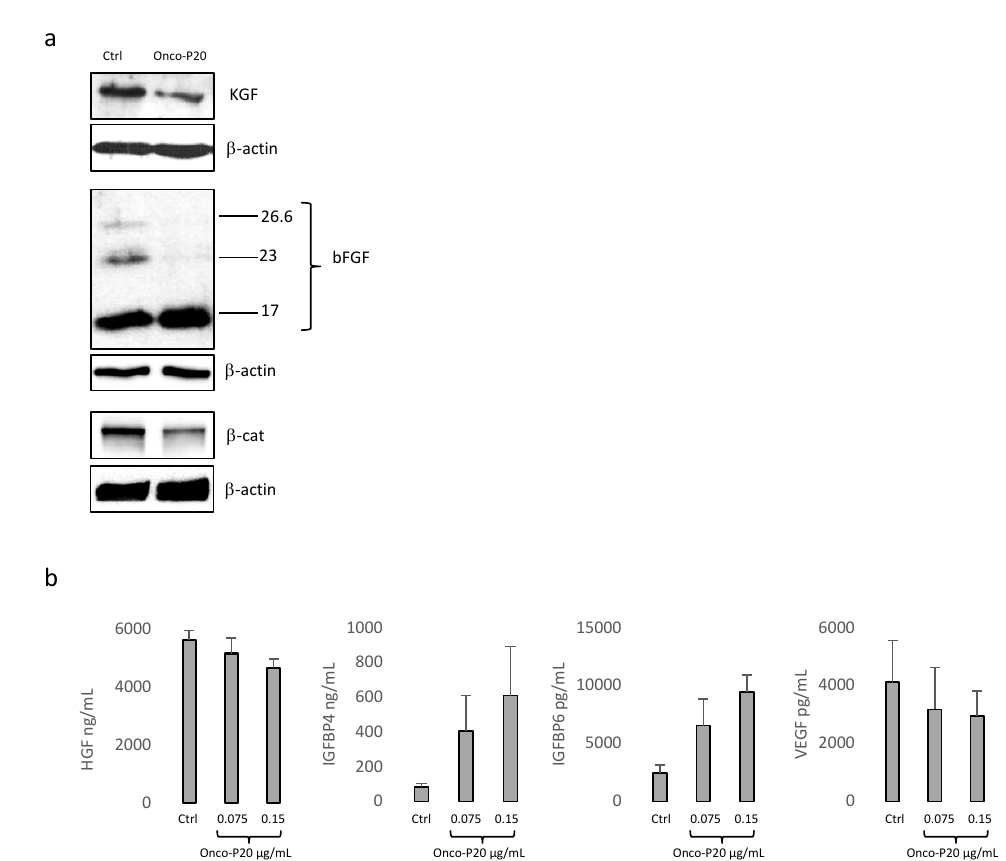
Figure 6. ( a ) One representative Western blot analysis demonstrating the reduction in growth factors and β -catenin expression in Onco-P20-treated (0.15 µ g/mL) NHFs. Proteins were extracted after 2 weeks of treatment. ( b ) Immuno- enzymatic quantification of IGFBP4, IGFBP6, and VEGF released in the cell culture medium. After 2 weeks of treatment, cells were incubated for an additional 48 h with DMEM without FBS before medium collection. Results were normalized against the protein